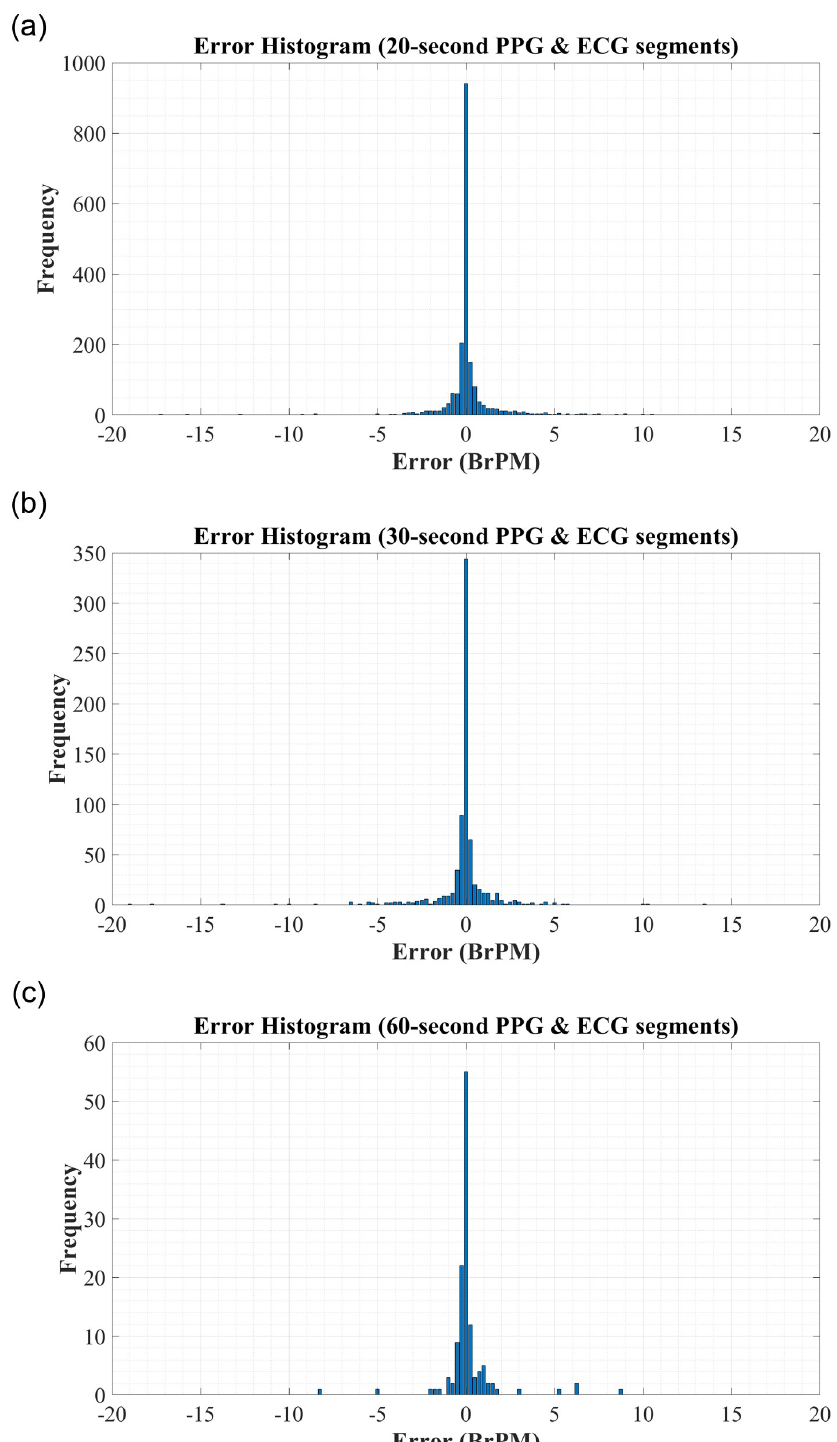
Fig 3. Error Histograms for RR Estimation using RR & RQI features derived from: (A) 20-second PPG & ECG segments. (B) 30-second PPG & ECG segments. (C) 60-second PPG & ECG segments.